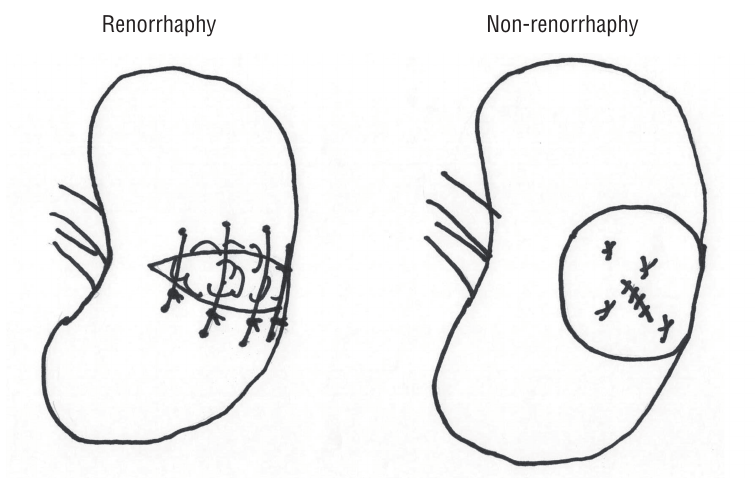
figure 1 - The illustration of the renorrhaphy and non-renorrhaphy